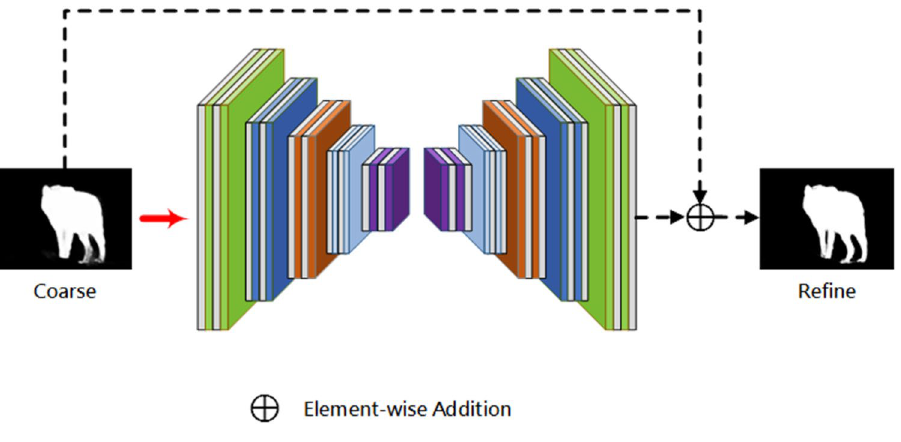
Figure 4. Residual